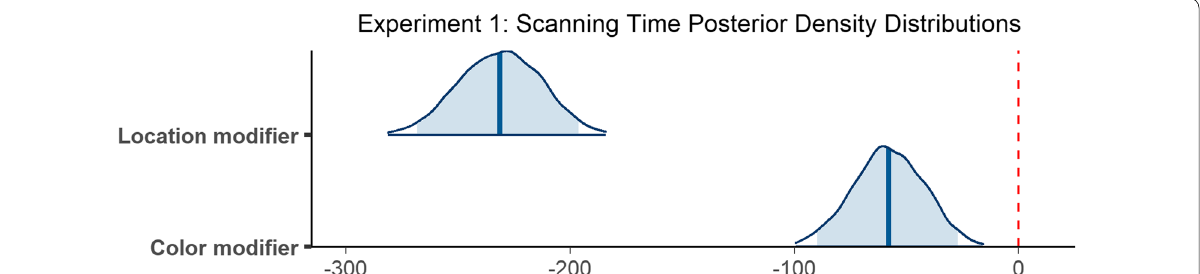
Fig. 5 Posterior density distributions for scanning time β parameter estimates for each level of the fixed effect relative to the reference level. Light blue shaded regions indicate the 95% credible interval and blue vertical lines indicate the mean of the distribution. The red vertical dashed line highlights 0 on the x axis. If the red line falls within the light blue shaded region, the estimate is not reliably different from zero and interpreted as a null result